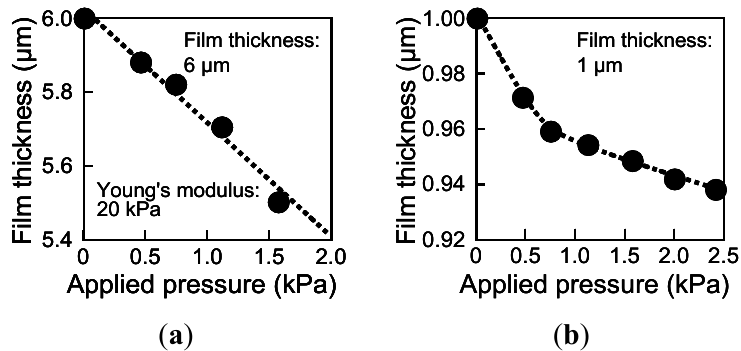
Figure 12. Thickness of polyurethane film in tactile sensor versus applied pressure, which is calculated considering both the initial thickness of polyurethane and the change in capacitance shown in Figure 11. ( a ) Change in thickness when initial thickness is 6 µm; ( b ) Change in thickness when initial thickness is 1